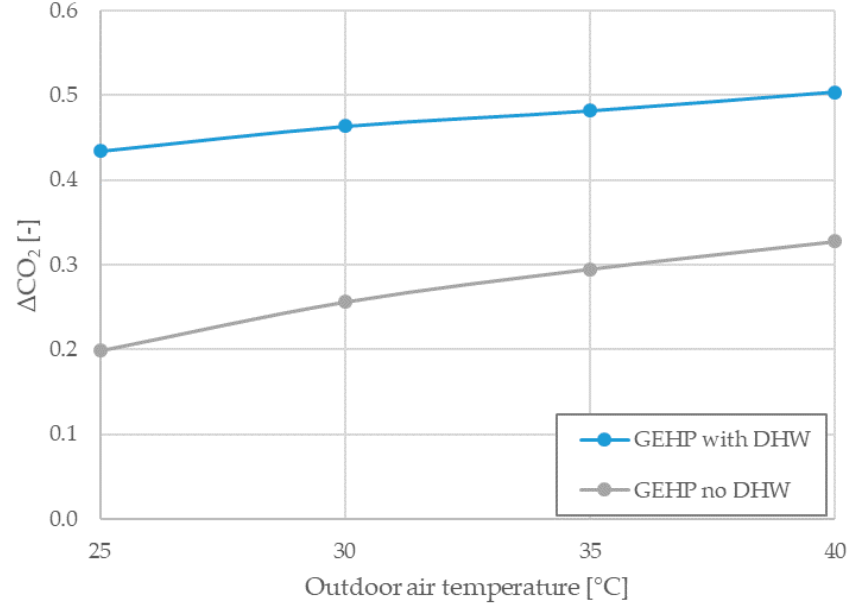
Figure 27. CO 2 emissions for GEHP and EHP/B systems as a function of outside air temperature.